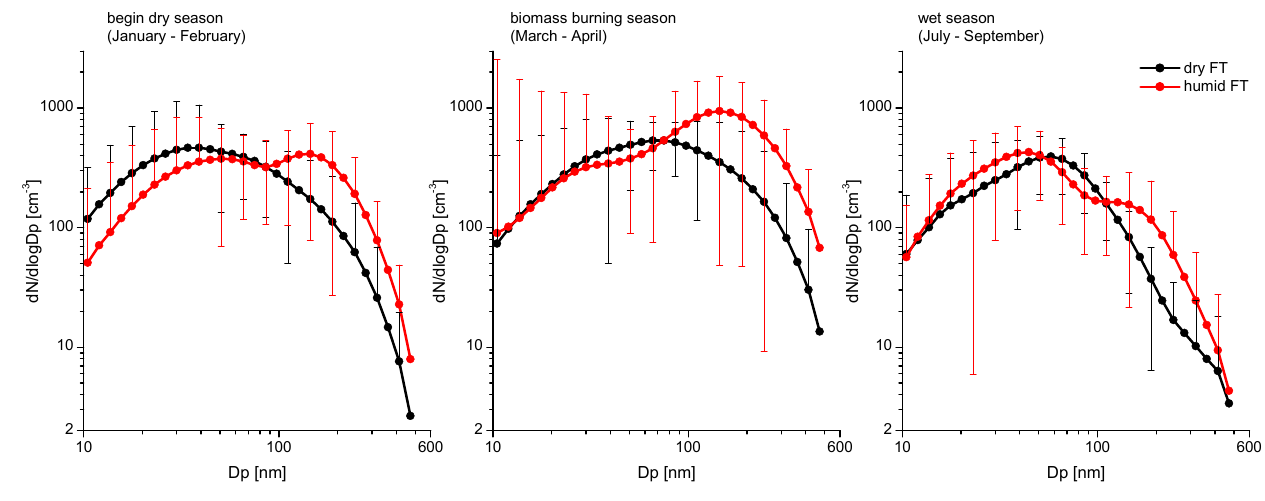
Fig. 3. Mean particle number size distributions covering the period March 2007–March 2009. Whiskers indicate one standard deviation.